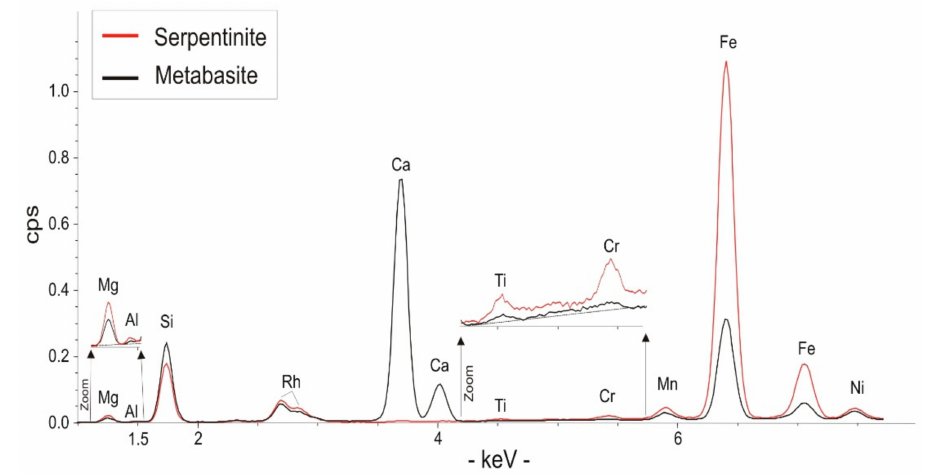
Figure 4. p-XRF spectra of serpentinitic and metabasitic